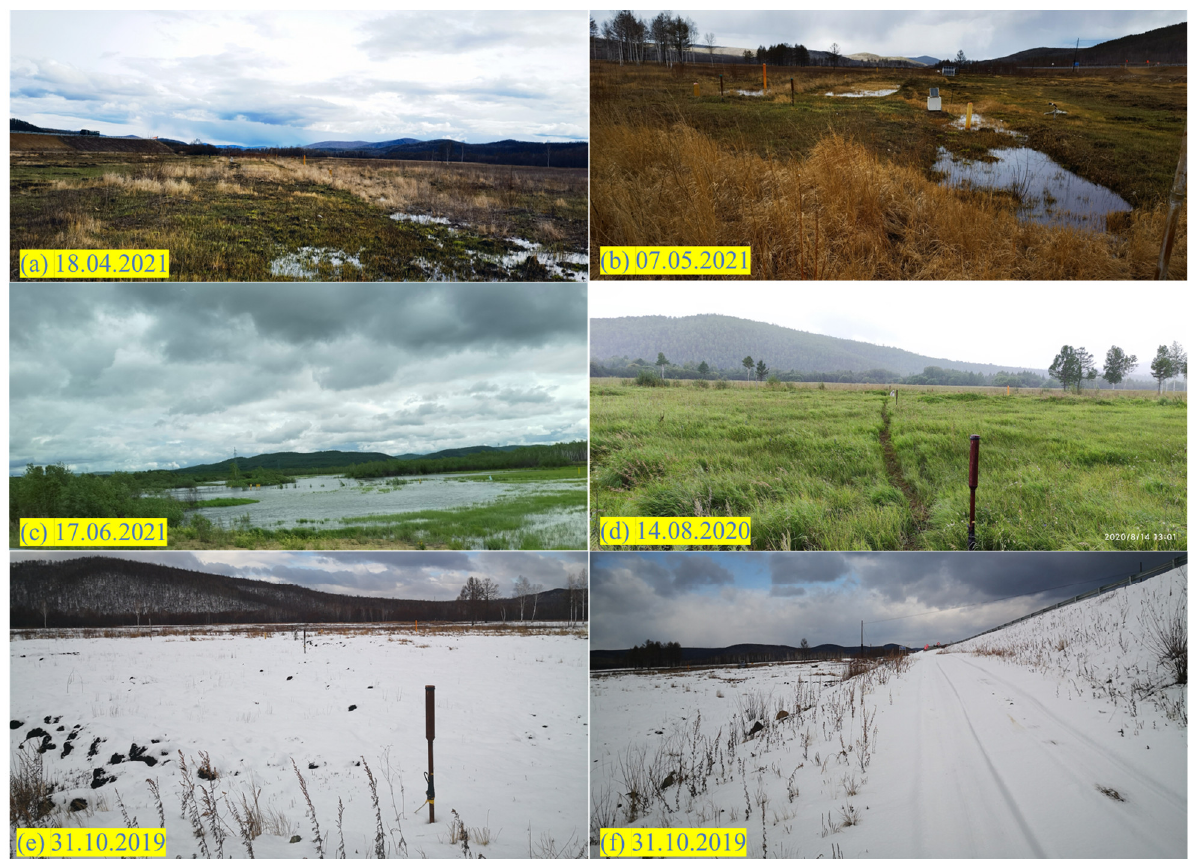
Figure 4. Seasonal landscape near the MDS304 site in Jinsong Town: ( a ) After the fire has removed the surface vegetation, the bare surface can still be seen in the spring (18 April 2021); ( b ) Apparent surface subsidence and stagnant water within the pipeline right-of-way (7 May 2021); ( c ) Occasional floods in summer cover the entire valley (17 June 2021); ( d ) Typical wetland type vegetation can be seen on the surface in summer (14 August 2020); ( e ) Less vegetation after the fire and thick snow can be seen in winter (31 October 2019); ( f ) Thicker snow cover on roads and slopes in winter (31 October 2019).